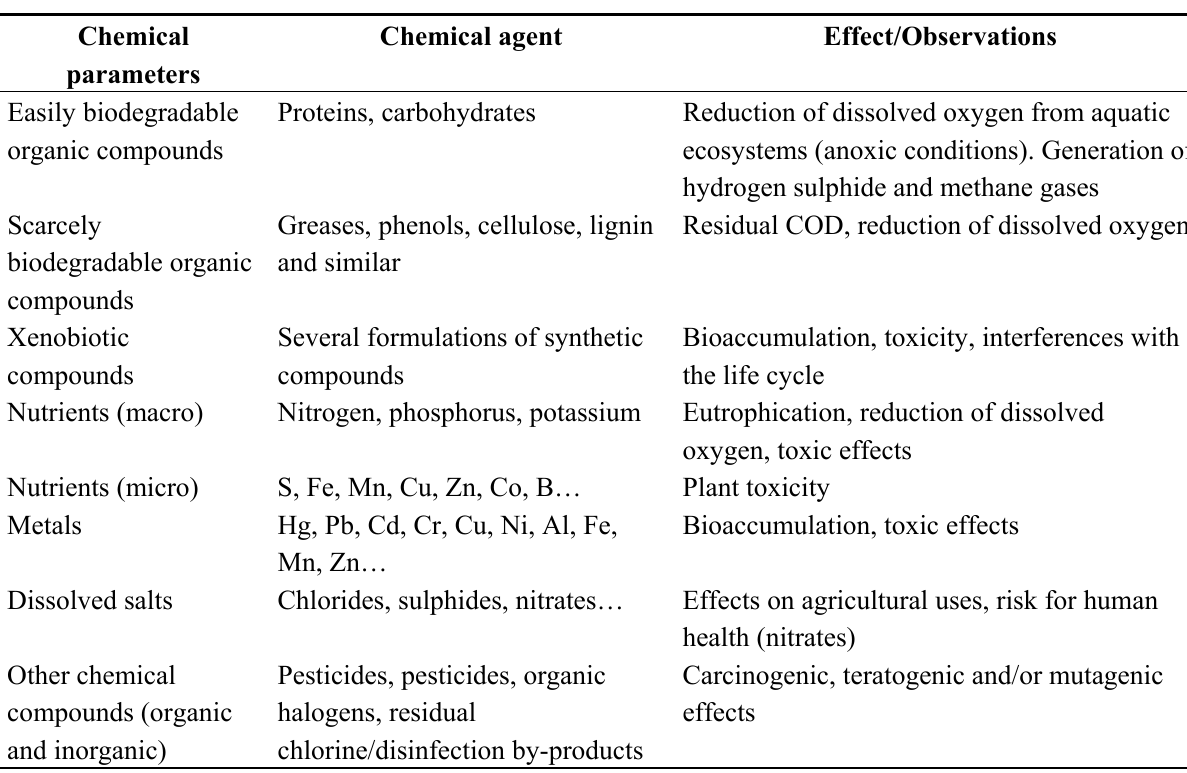
Table 6. Chemical agents of concern potentially present in municipal wastewater (modified from